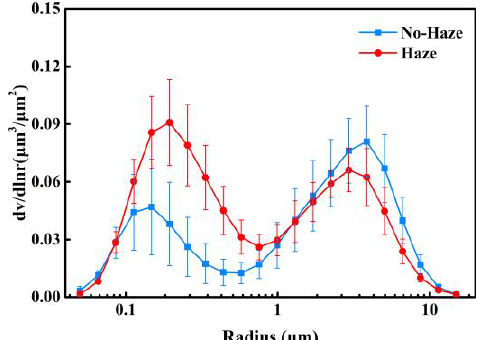
Figure 3. Time series of the aerosol volume size distribution.